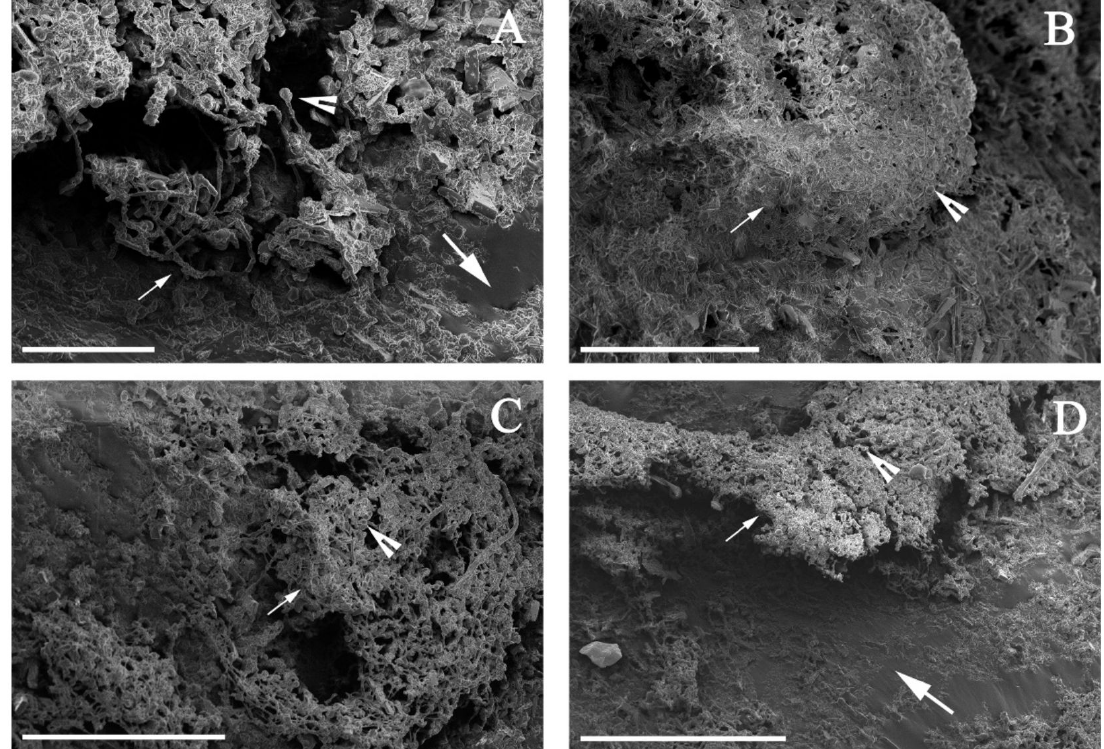
Figure 6. Scanning electron microscopy of Alternaria sp. grown in Czapek minimal medium containing 0.5% w/v of extra- heavy crude oil (7–10 ◦ API). ( A ) Hyphae (small arrows), conidia (arrowheads), and smooth petroleum surface (arrows). Scale bar = 100 µ m. ( B ) Mycelium (small arrows) and conidia (arrowheads). Scale bar = 200 µ m. ( C ) Hyphae (small arrows) and conidia (arrowheads). Scale bar = 300 µ m. ( D ) Mycelium (small arrows), conidia (arrowheads), and petroleum (arrows). Scale bar = 500 µ m. In all images, the mycelium is in tight contact with the petroleum surface. For both Penicillium spp., the maximum average amount of protein (40.5 ± 1.2 mg/L for Penicillium 1 and 46.0 ± 13.7 mg/L for Penicillium 2) was obtained for the cultures amended with 0.75% v/v light crude oil (Figure S1). The protein concentration in